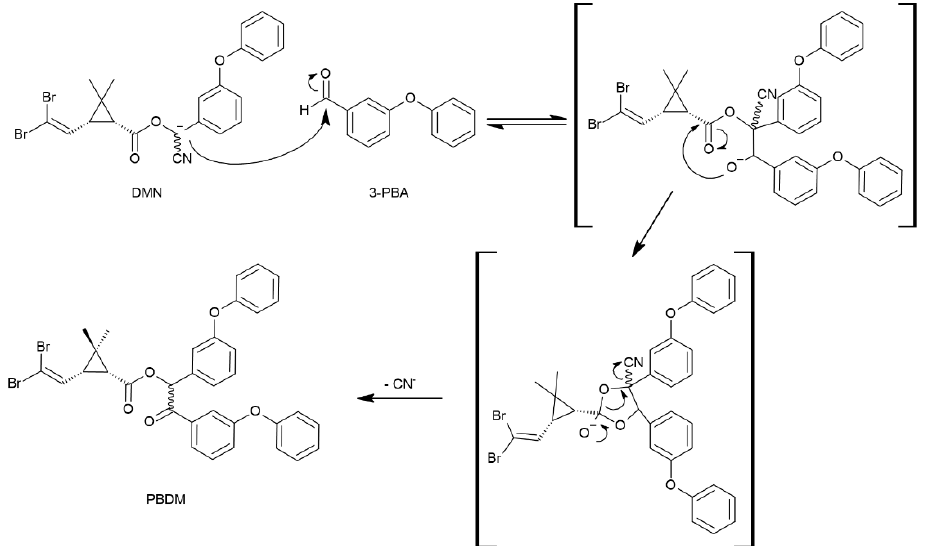
Scheme 2. Suggested reaction mechanism involving DLM and PBA, with formation of two PBDM diastereomeric species.